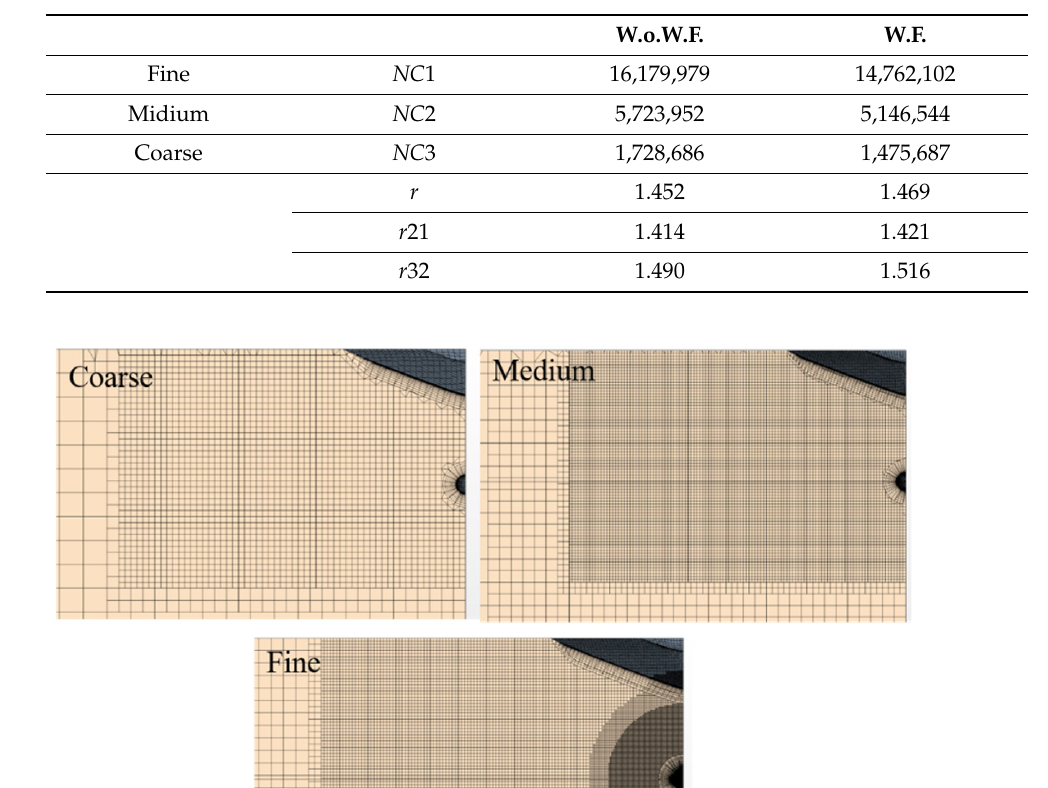
Table 3. Results of grid refinement ratio r i .